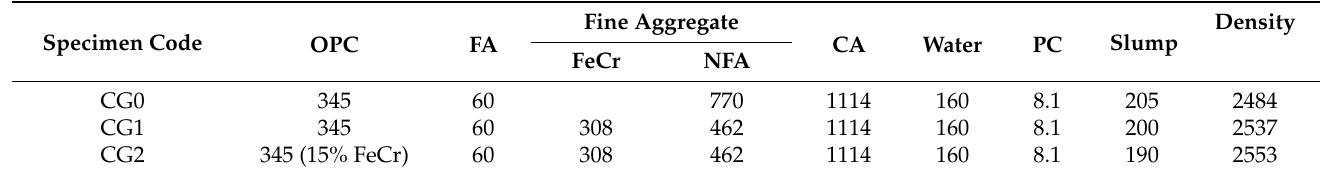
Table 5. Mix proportion of ferrochrome slag